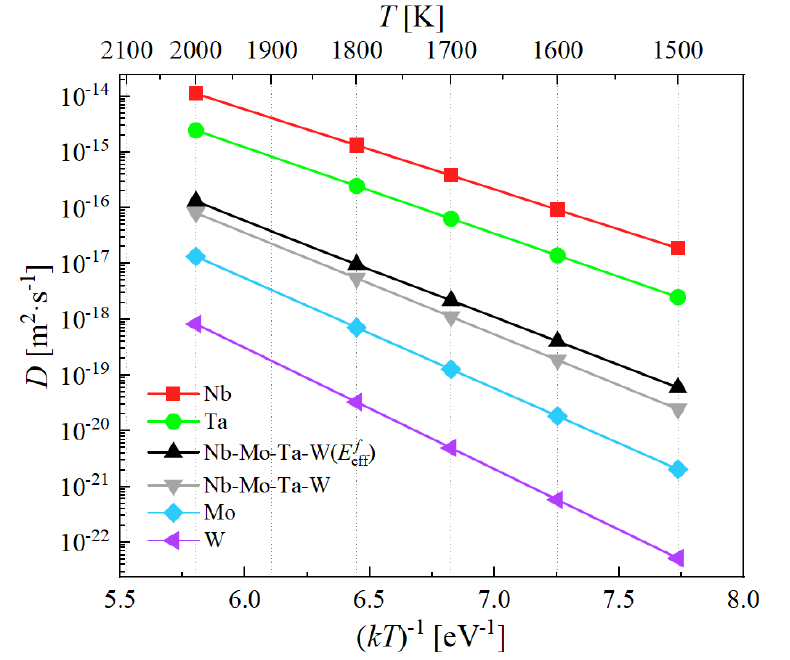
Figure 11. Diffusivities of Nb-Mo-Ta-W and its pure constituents as a function of